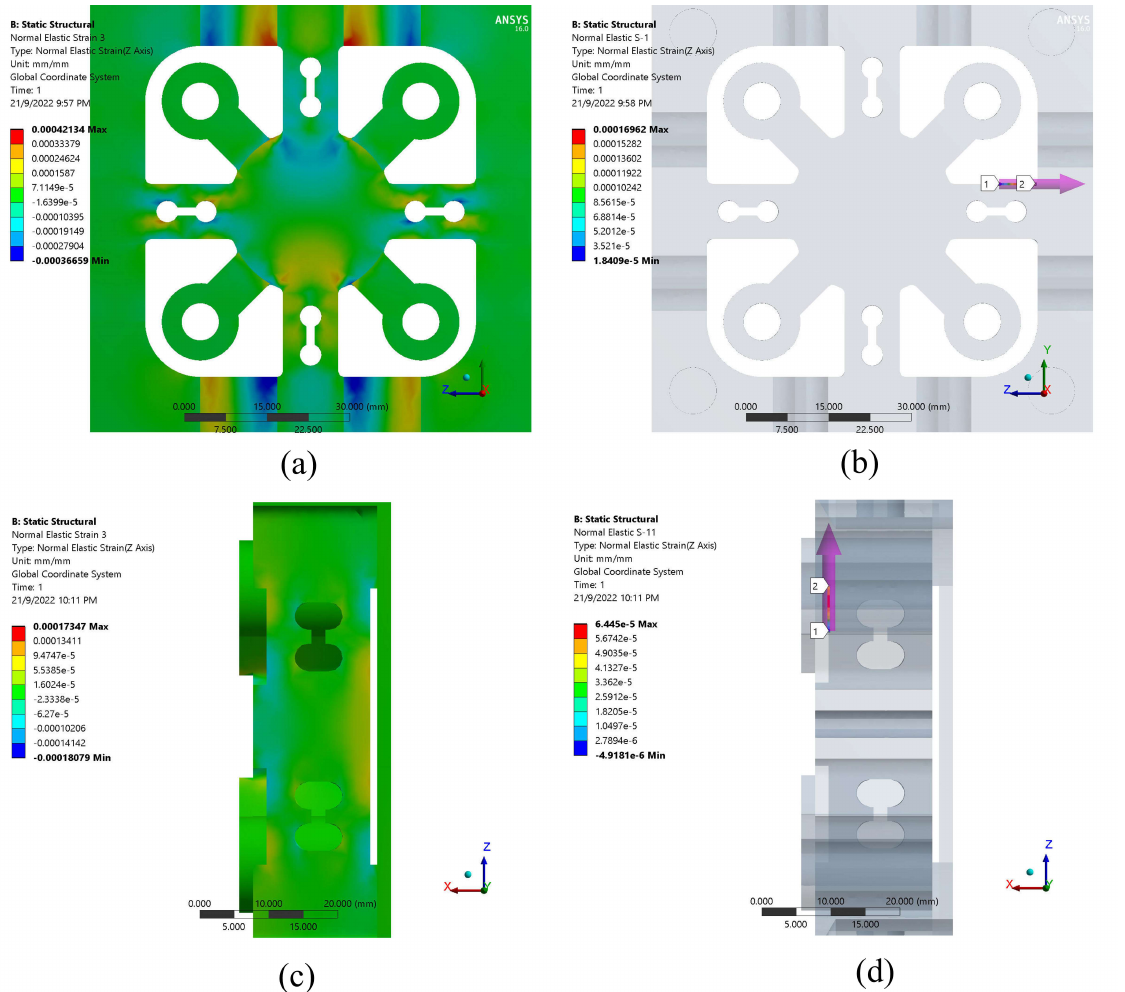
Figure 5. Strain distribution on cross-beam surfaces while under: ( a , b ) F x force; ( c , d ) F z force. A plot of the normal strain along the cross-beam midlines as it appears on their surfaces is shown in Figure 6. Because of the symmetrical nature of the construction, the normal strain was distributed in a manner that was similar along both the x and y axes. Due to the force F x operating on the force transducer, the maximum strain on the x -axis was 0.75 microstrain at locations 4 to 6 mm in Figure 6a. In comparison, the strains on the y and z axes were 0.005 and − 0.2 microstrain at the same position. This suggests that the interference strain that was caused by a force F x on the y and z channels was relatively small or even nonexistent. The highest amount of strain that was measured as a result of a radial force, denoted by F z , was 0.13 microstrain, whereas the amount of strain that was measured in the x and y channels was around 0.004 and − 0.0002 microstrain,